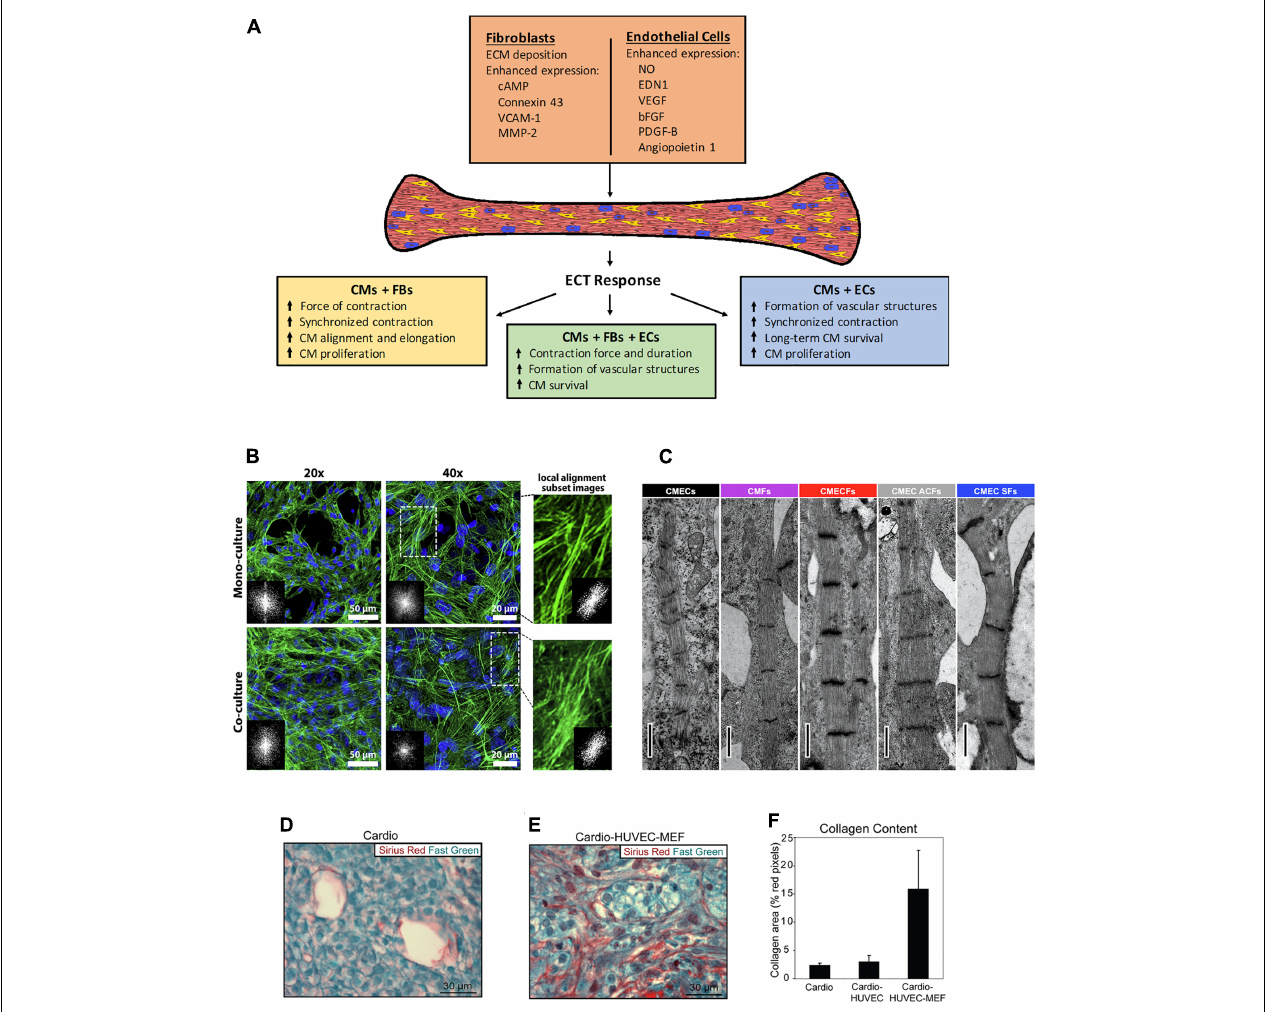
FIGURE 1 | (A) Schematic of the effects observed in engineered cardiac tissues fabricated with the inclusion of non-CMs, and the potential mechanisms involved. CMs, cardiomyocytes, FBs, fibroblasts, ECs, endothelial cells. (B–E) Histological representation of effects from co-culture in various types of 3D microenvironment. (B) The cytoskeleton organization and analysis of F-actin fiber alignment within PNJ-Gelatin hydrogel 3D microenvironment. F-actin fibers (green) stained images in monoculture of neonatal rat ventricular CMs and co-culture of CMs-CFs (2:1 ratio). Both culture groups representing the cytoskeleton organization at 20 and 40 magnifications; FFT images (inset) indicate fiber alignment within the formed 3D cardiac tissue. The magnified spots and related inset FFT images illustrate the local alignment of F-actin fibers. (C) Cardiac fibroblasts promote structural maturation of hiPSC-CMs in microtissues. Representative transmission electron microscopy images showing sarcomeres in different microtissues. Scale bar: 1 mm. Cellular composition of cardiac scaffold free 3-D microtissues as follows – CMECS: 85% hiPSC-CMs +15% hiPSC-ECs; CMFs: 85% hiPSC-CMs +15% hiPSC-CFs; CMECFs: 70% hiPSC-CMs +15% hiPSC-ECs+15% hiPSC-CFs; CMEC ACFs: 70% hiPSC-CMs +15% hiPSC-ECs+15% human adult cardiac fibroblasts (ACFs); CMEC SFs: 70% hiPSC-CMs +15% hiPSC-ECs+15% skin fibroblasts (SFs). (D–F) “Tri-cell” cardiac patches containing hESC-derived cardiomyocytes, HUVECs, and mouse embryonic fibroblasts (MEFs) in 1:1:0.5 ratios, respectively; (cardio-HUVEC-MEF patches) had more collagen fibrils compared with cardio-only and cardio-HUVEC patches. Patch sections were stained by using Sirius red (collagen) and fast green (other tissue elements). Representative cardio-only (D) and cardio-HUVEC-MEF (E) patches. (F) Cardio-HUVEC-MEF patches had greater than fivefold collagen per unit area than cardio-only or cardio-HUVEC patches. Adapted and reprinted with permission from (B) (Navaei et al., 2016), (C) (Giacomelli et al., 2020, doi: 10.1016/j.stem.2020.05.004, https://creativecommons.org/licenses/by/4.0/), and (D–F) (Stevens et al.,